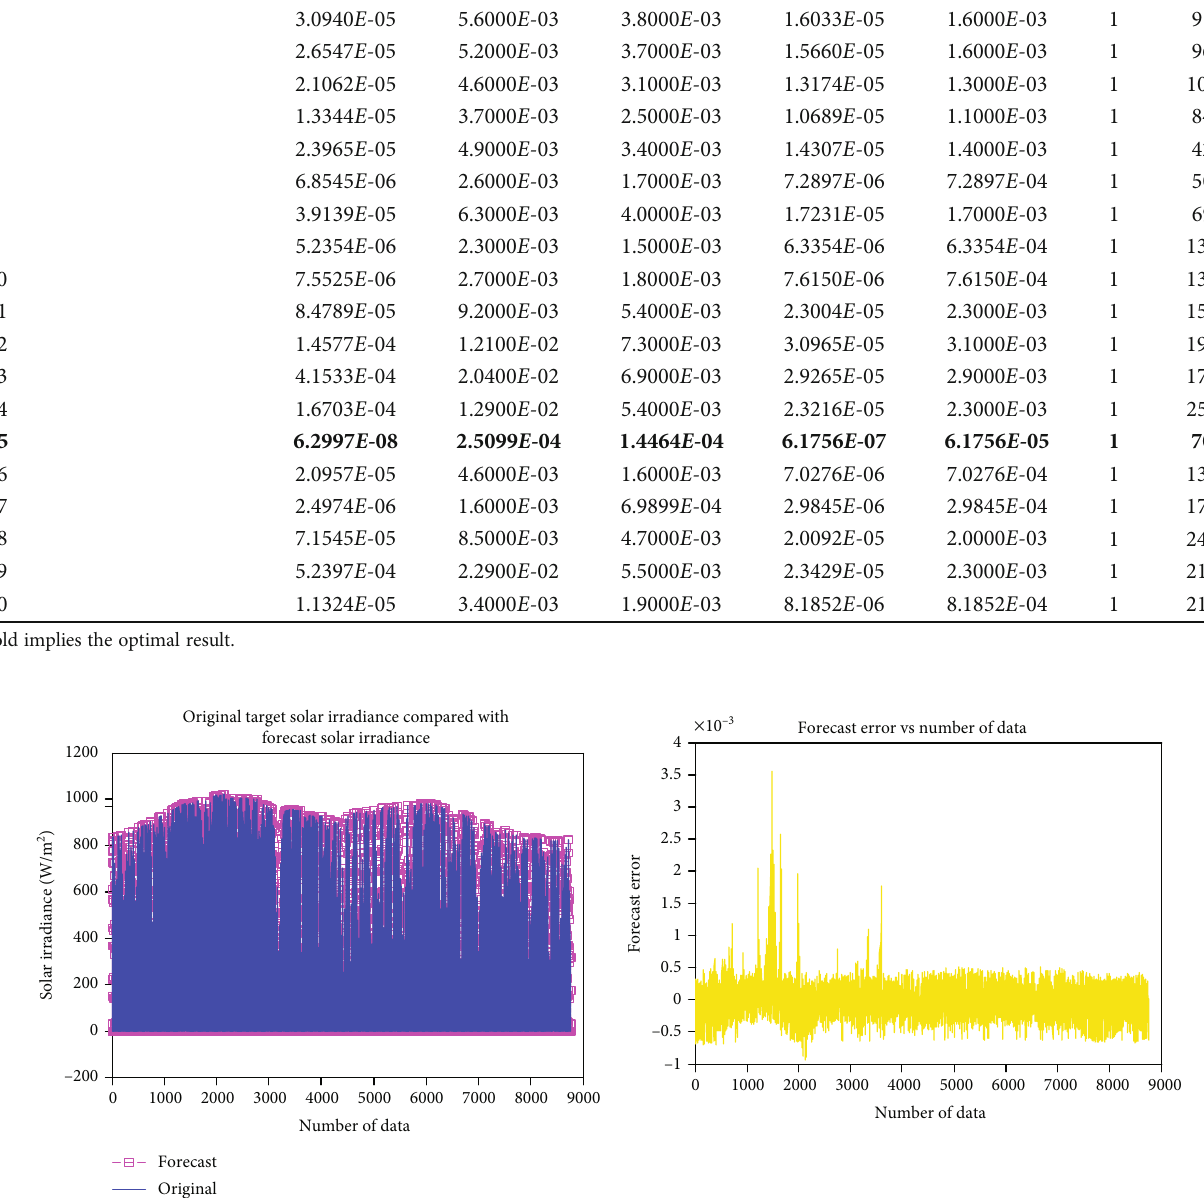
Table 5: Four input multilayer perceptron neural network performance analyses with di ff erent numbers of hidden neurons. Number of hidden neurons